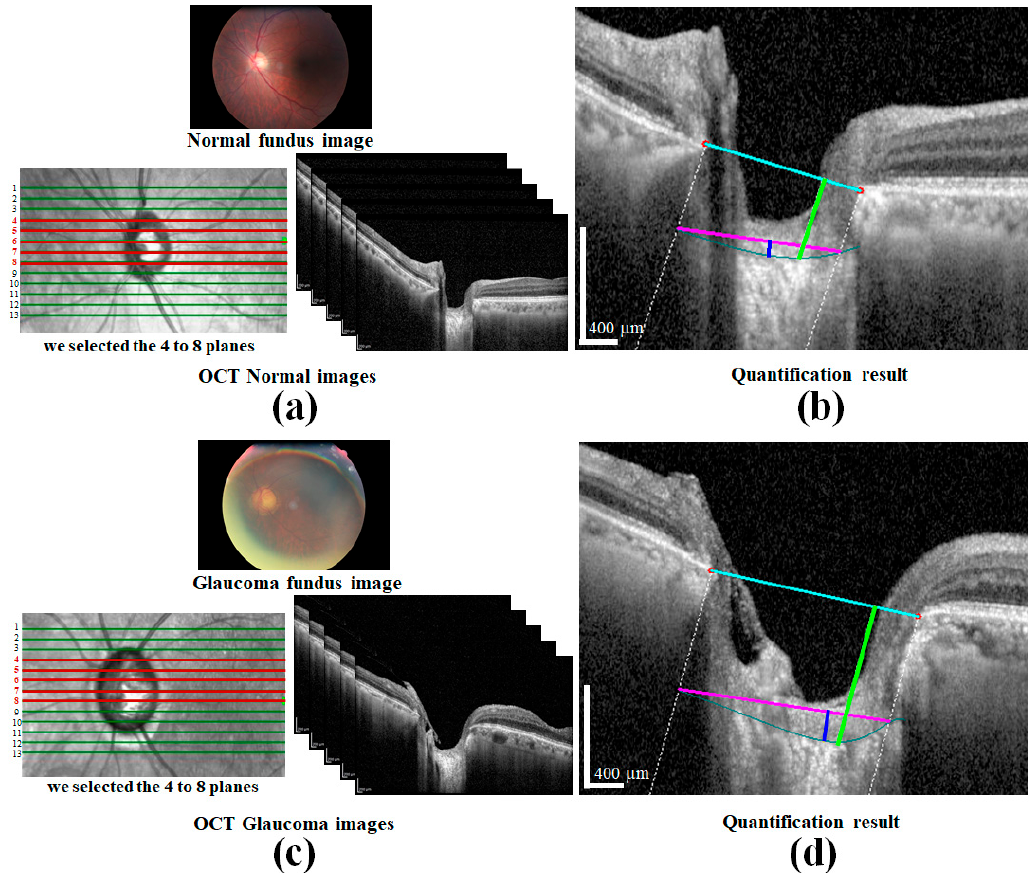
Figure 12. Correlation between the predicted vs. ground-truth values: ( a ) The correlation between prediction and ground- truth for LCD was around R² = 0.9649. ( b ) The correlation between prediction and ground-truth for LCCD was around R² = 0.6112. ( c ) The correlation between prediction and ground-truth for LCCI was around R² = 0.7015.